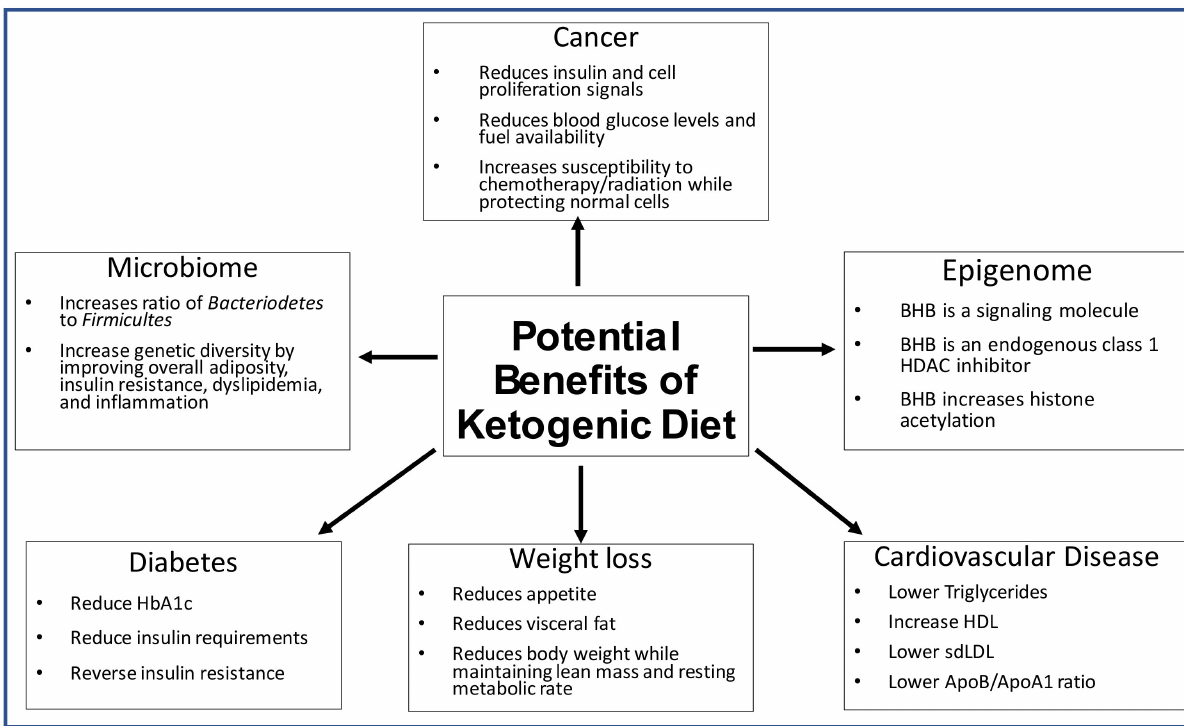
Figure 3. The potential therapeutic impacts of the ketogenic diet on the microbiome, epigenome, diabetes, weight loss and cardiovascular